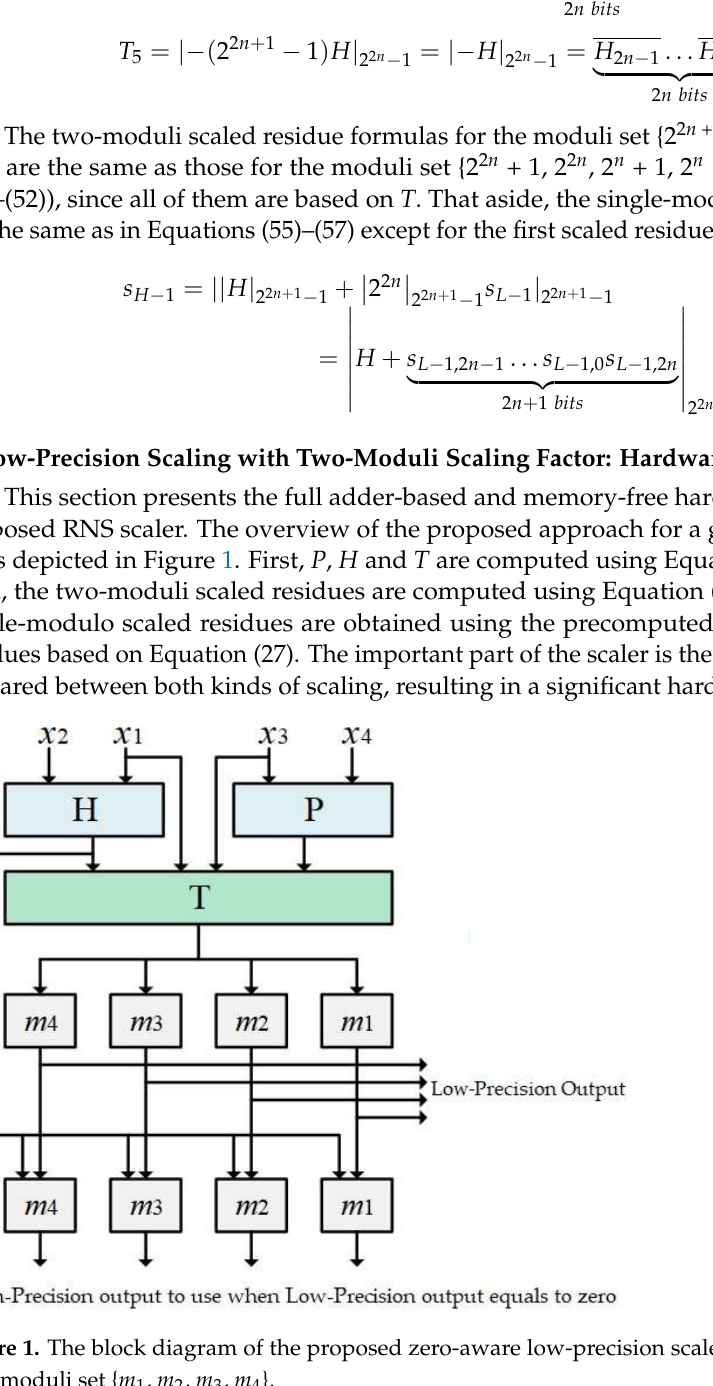
Figure 1. The block diagram of the proposed zero-aware low-precision scaler for the generic RNS four-moduli set { m 1 , m 2 , m 3 , m 4 }.